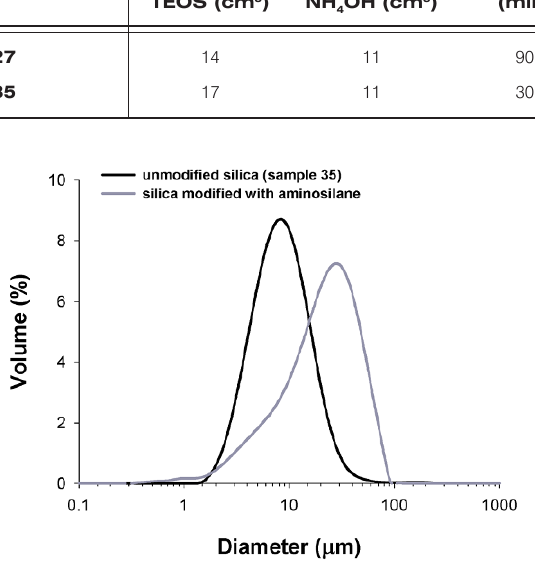
Table 2. Silica samples of the best dispersive–morphological properties and their synthesis parameters. Sample No.